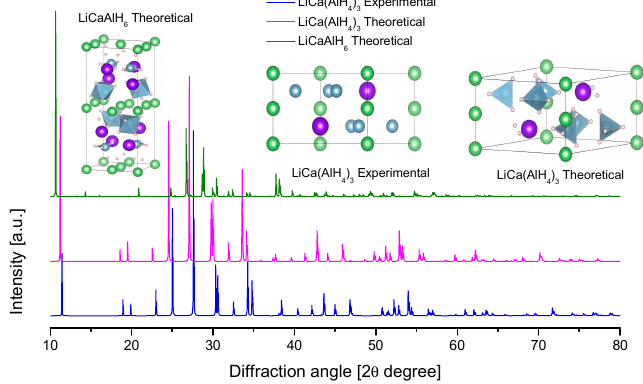
Figure 25. Crystal structure of Li-Ca mixted alanate and its calculated diffraction patterns ( λ = Cu k α 1 ).